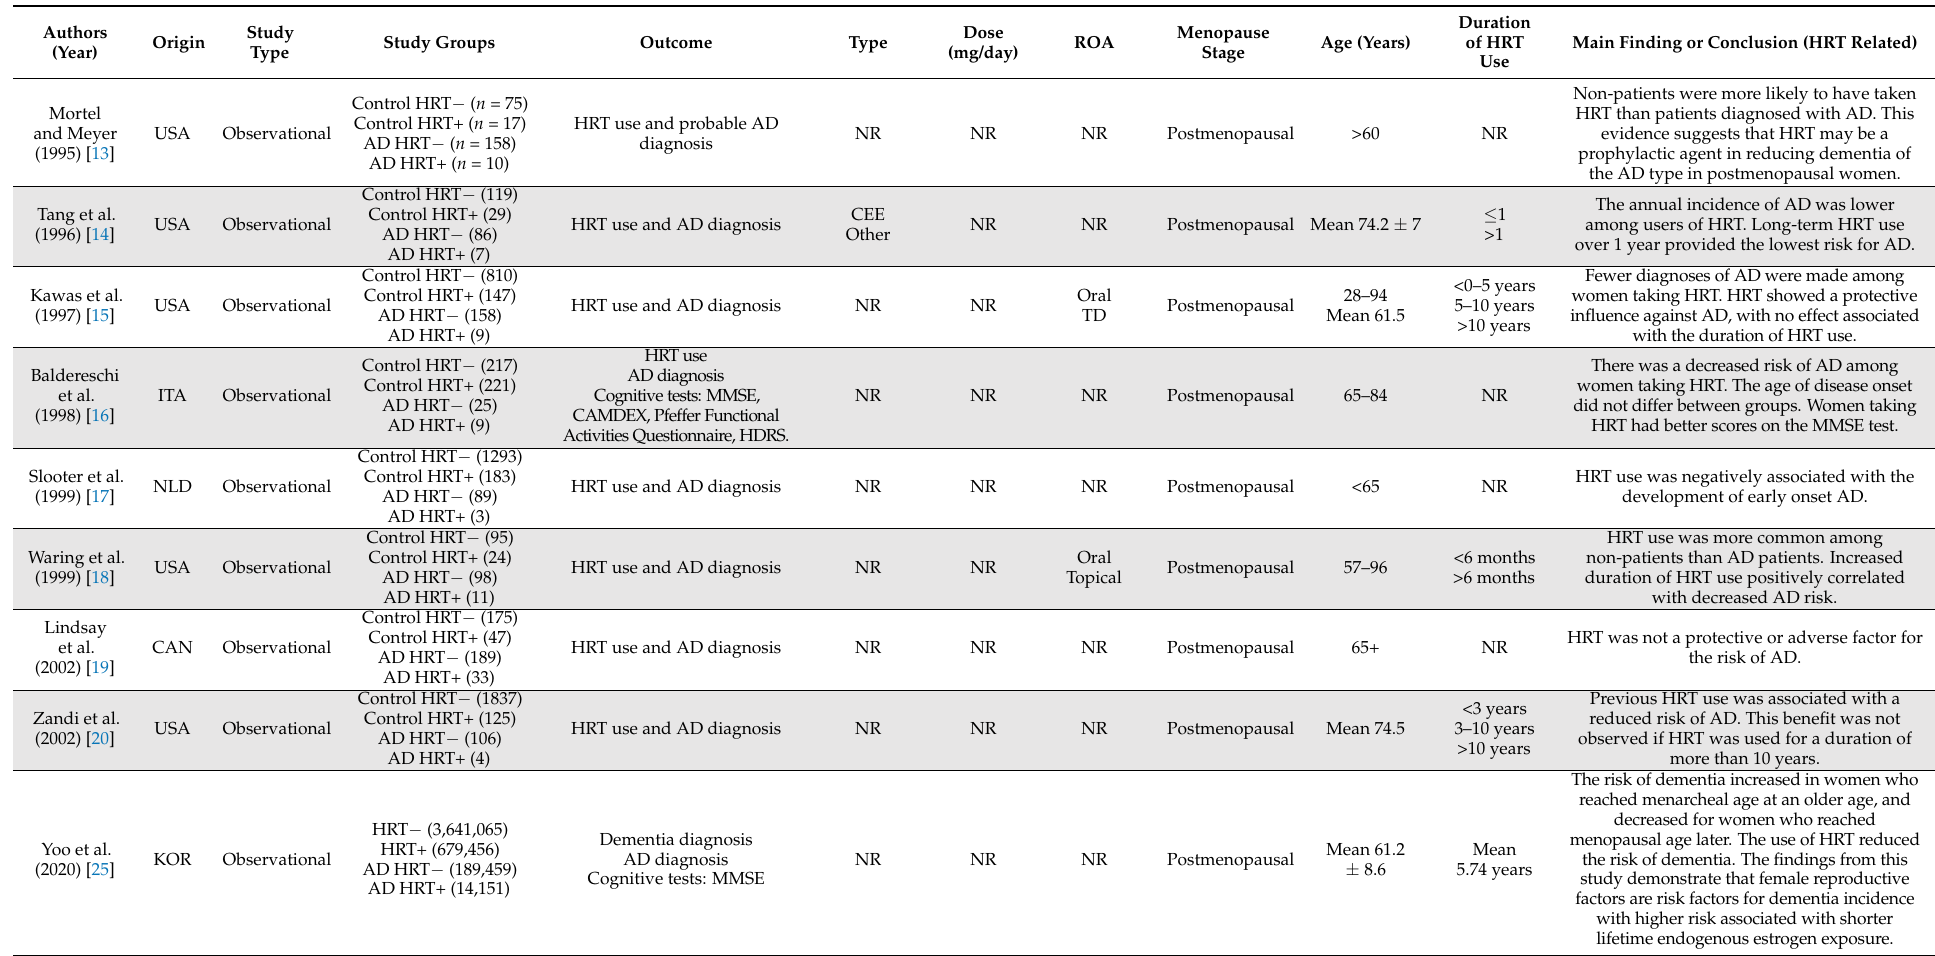
Table 1. Summary of human observational and clinical studies included in this